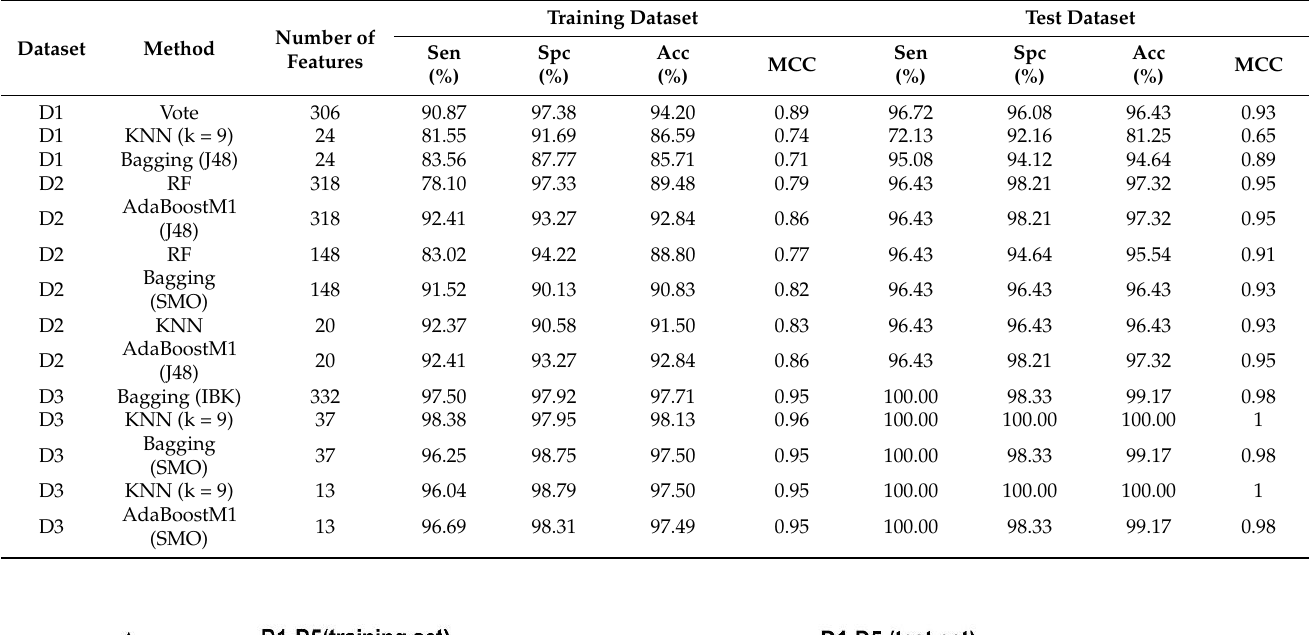
Table 1. In the ACPs datasets D1, D2 and D3, excellent models were constructed based on multiple algorithms and different features.